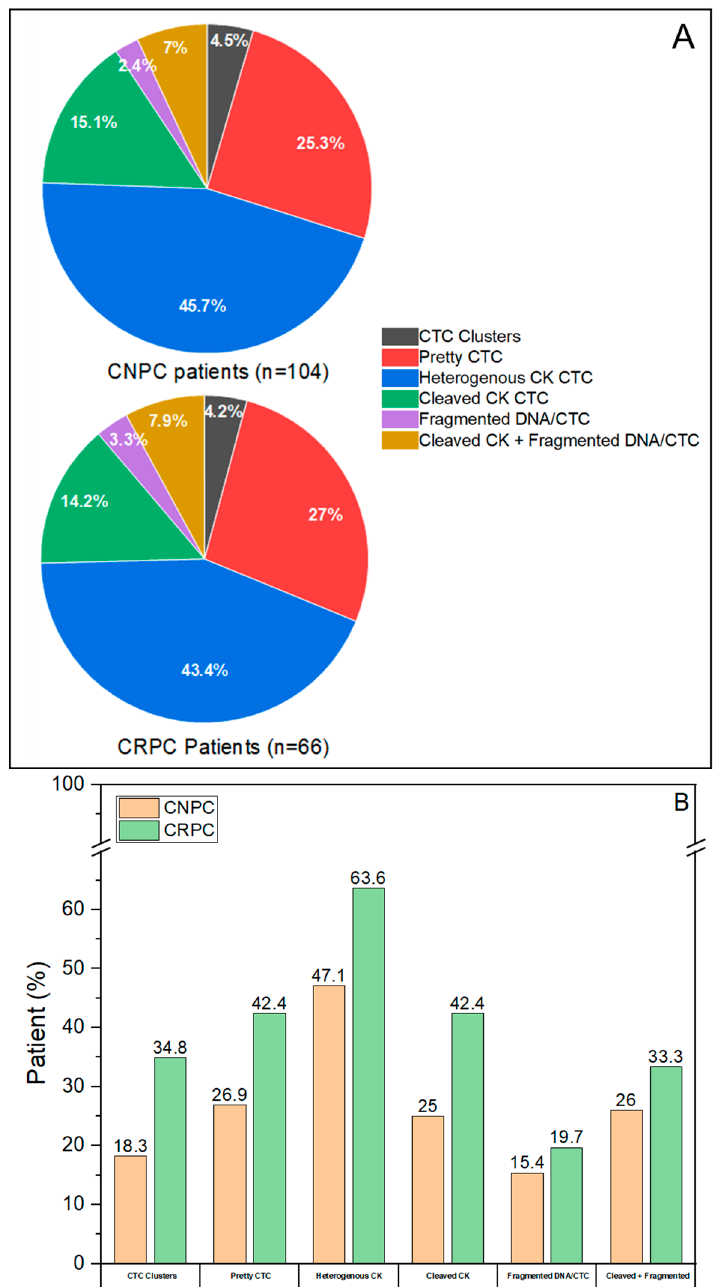
Figure 6. CNPC (n = 104) and CRPC (n = 66) patients exhibiting CTC subclasses. ( A ): Distribution (%) of total CTCs of CNPC and CRPC patient cohorts into the different CTC subclasses ( B ): Patients (%) in CNPC and CRPC showing the presence of CTC subclasses. A higher percentage of CRPC patients have CTCs in each CTC subclass.